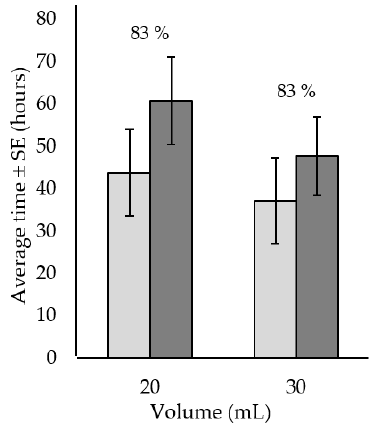
Figure 1. The effects of citric acid concentration and the number of injections. Mean time to immobility ( ) and to death ( ) ± standard error for Acanthaster cf. solaris injected with 20 mL of citric acid and seawater solution at concentrations of 90, 120, and 150 g L − 1 in one ( i ), two ( ii ) and four ( iii ) injection sites (I.S.). Numbers above bars represent total percent mortality; where no numbers are shown, mortality was equal to 100%. For the 150 g L − 1 , 4 I.S. treatment, time to immobility was assumed to equal time to death ( ). Six replicates per treatment combination were used. Letter notations above bars (a, b, c) indicate Tukey’s post-hoc groupings between injection site treatments and concentrations for time to death. Different letters indicate significant differences among treatments.